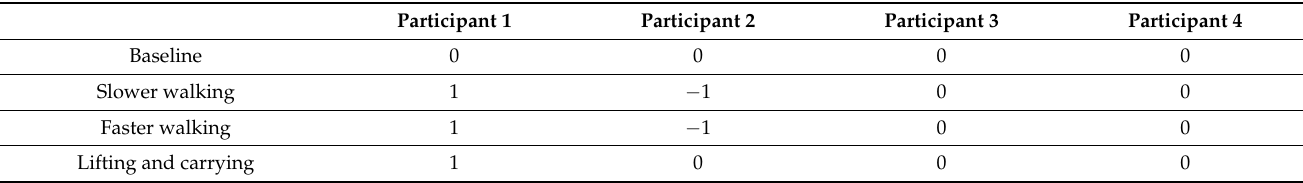
Table 2. Thermal Sensation results for each participant for the Loose Leg Sleeve, where − 4 represents very cold, − 3 cold, − 2 cool, − 1 slightly cool, 0 neutral, 1 slightly warm, 2 warm, 3 hot, and 4 very hot.